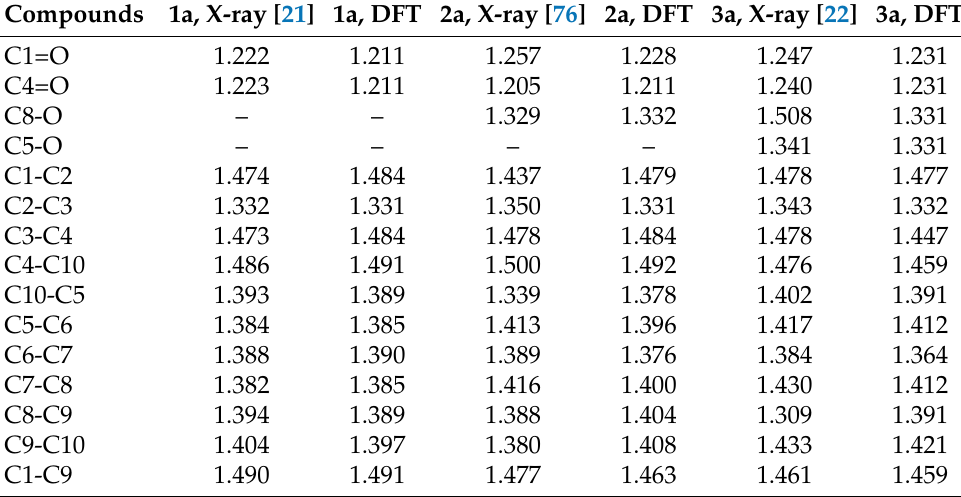
Table 2. Selected experimental (X-ray) and calculated ( ω B97XD/6-311++G(2d,2p) level) bond lengths (in Å) for the parent compounds 1a , 2a , 3a —see Figure 1 for the atom numbering scheme and structural overview.